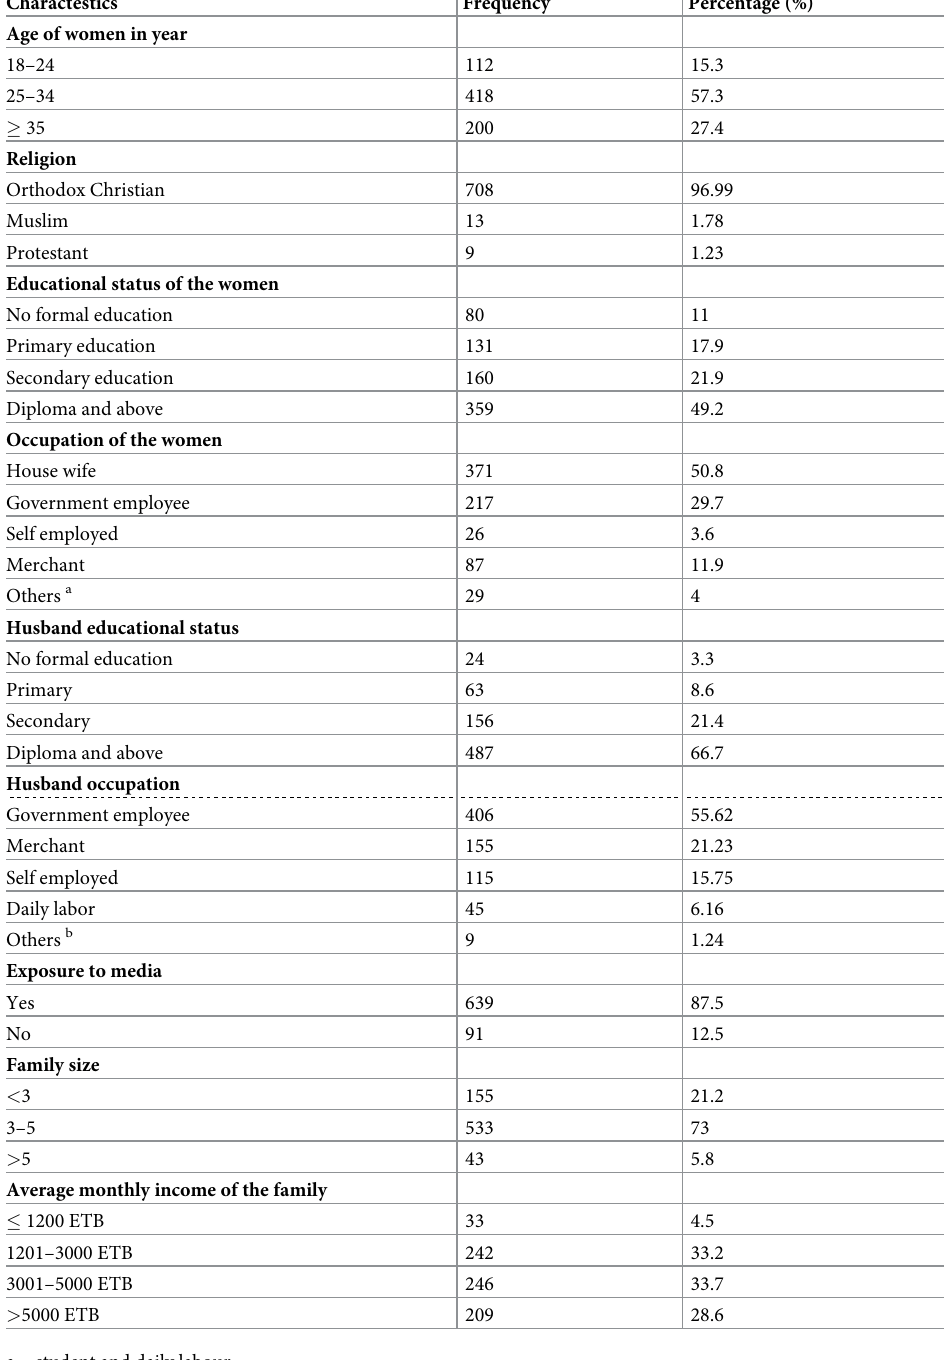
Table 1. Socio-demographic characteristics of study participant in Debretabor, Northwest Ethiopia, 2019 (n =